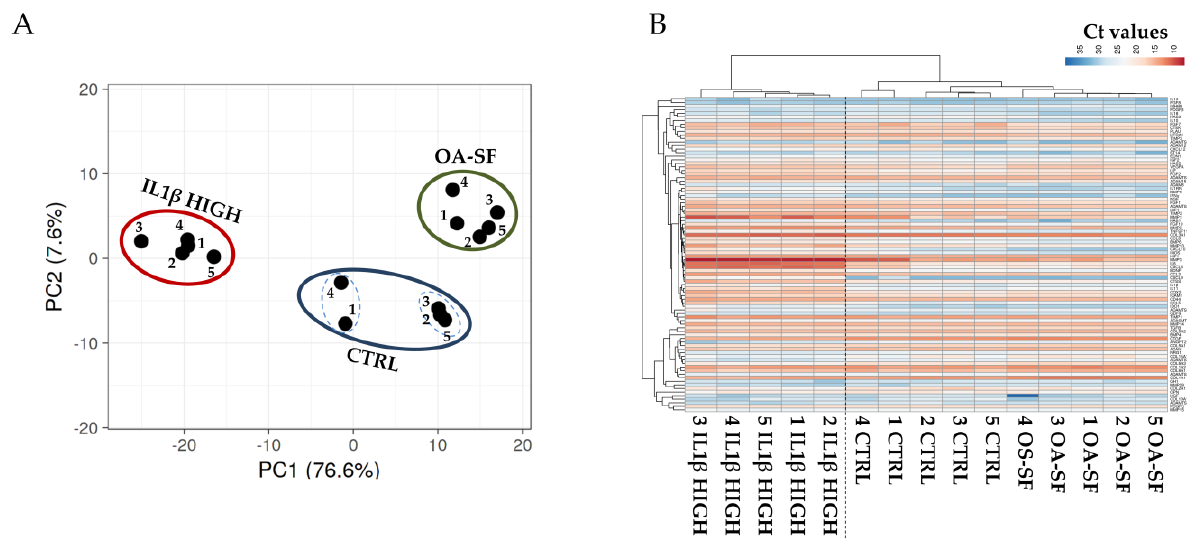
Figure 7. PCA ( A ) and heatmap ( B ) showing differential expression of 88 genes between control (CTRL) and stress treatments (abbreviations in Figure 2) in the previously analyzed three HCH donors (1/2/3) and two new independent ones (4/5). In the heatmap, red shades indicate higher expression and blue shades indicate lower expression. Color key indicates the intensity associated with normalized C t values.